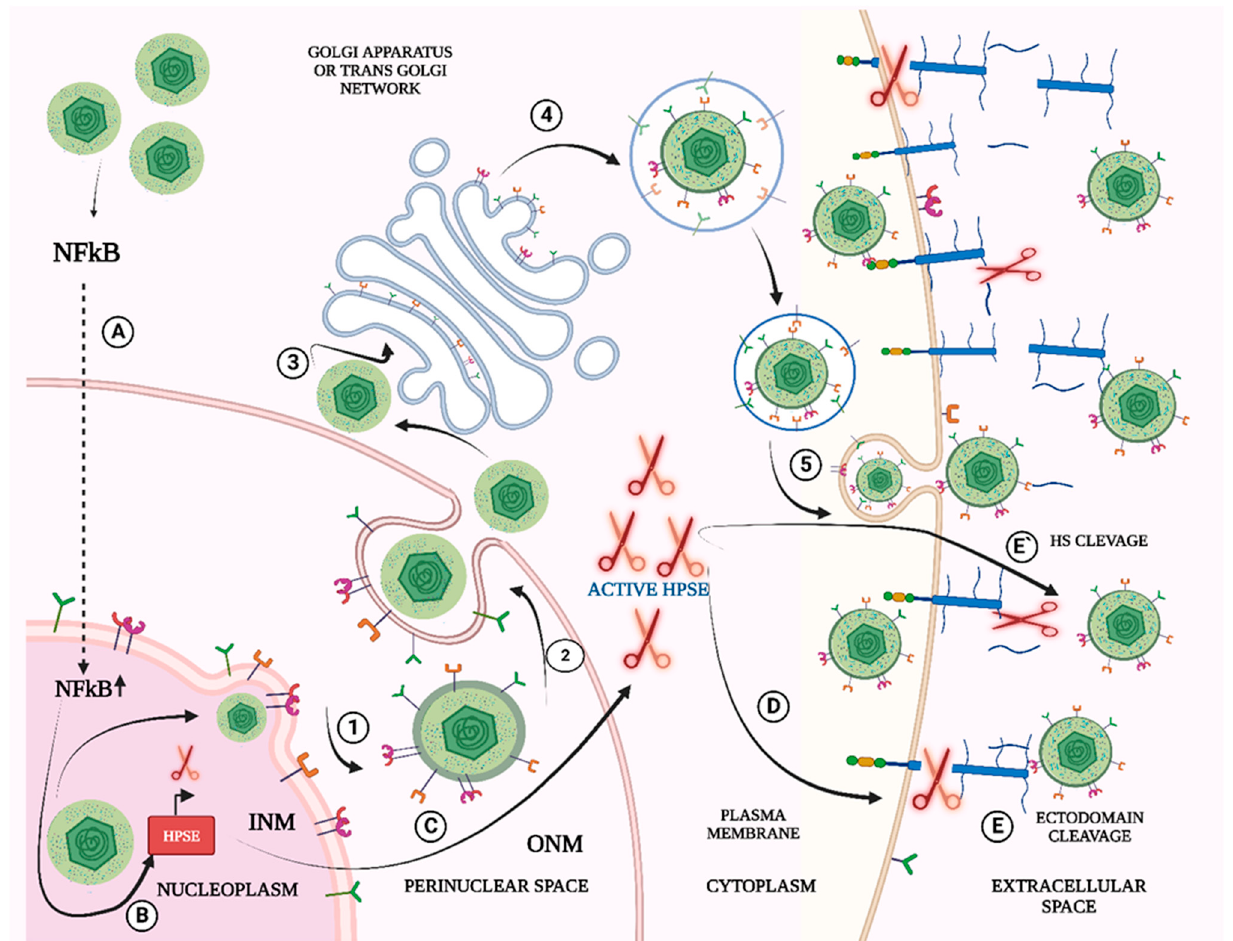
Figure 2. OVERVIEW OF HSV-1 RELEASE. ( 1 – 2 ) After capsids are formed in the nucleus, they bud into the inner nuclear membrane (INM) (primary envelopment) to form an enveloped particle in the perinuclear space. These particles fuse with the outer nuclear membrane (ONM) (de-envelopment) and are released into the cytoplasm, leaving the envelope in the ONM. ( 3 – 4 ) In the cytosol, capsids bind onto trans Golgi network and bud into cytoplasmic membranes (secondary envelopment) ( 5 ) and enveloped virions are ready to be secreted from cells (release). HPSE IN VIRAL RELEASE. ( A ) Entry of HSV-1 into the host cells stimulate the translocation of NF-kB from the cytoplasm to the nucleus. ( B – D ) NF-kB translocation further upregulate heparanase (HPSE) in the cytoplasm that travels to the extracellular membrane and aids in ( E ) heparan sulfate cleavage and ( E’ ) Cleavage of syndecan-1 ectodomain that aids in enhanced release of virions from the infected host cell. [Created in bioRender].